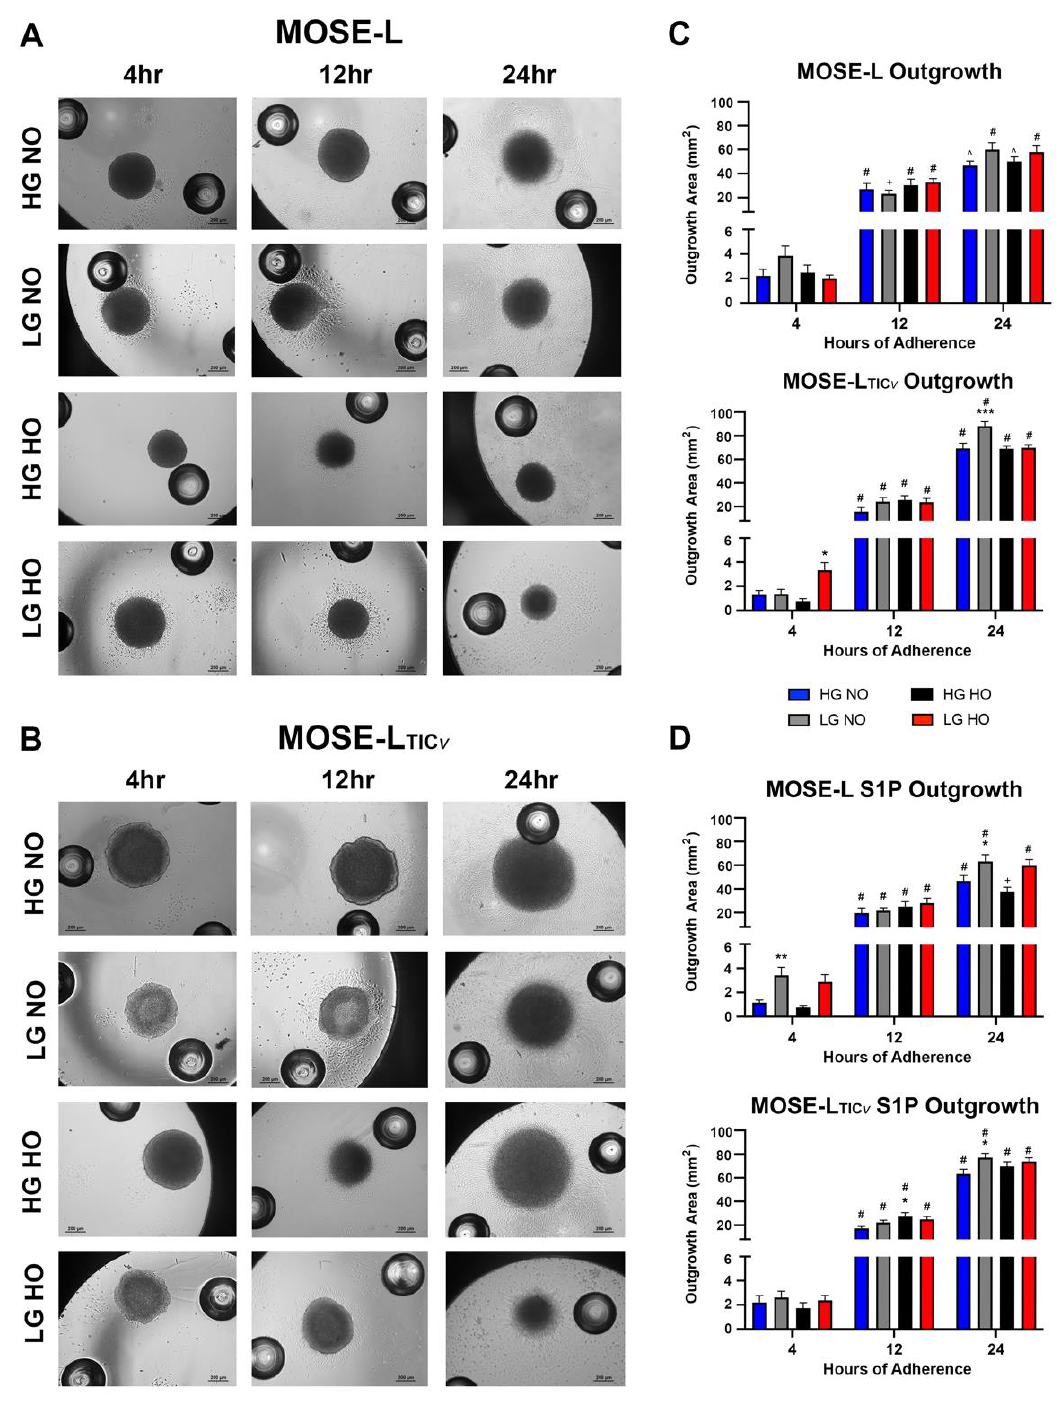
Figure 3. Spheroid outgrowth increased over time of adherence. Outgrowth of spheroids was measured in MOSE-L and MOSE-L TICv in brightfield images quantified using NIS Elements and ImageJ ( A ) Representative images of MOSE-L spheroids ( B ) Representative images of MOSE-L TIC v spheroids, ( C ) Quantification of outgrowth for MOSE-L and MOSE-L TICv spheroids, and ( D ) for S1P-treated MOSE-L and MOSE-L TICv . Data are represented as the mean ± SEM. * p < 0.05 compared to HG NO; ** p < 0.01 compared to HG NO; *** p < 0.001 compared to HG NO. + p < 0.05 compared to previous time point; ˆ p < 0.01 compared to previous time point; # p < 0.001 compared to previous time point. Abbreviations: high glucose (HG); low glucose (LG); normoxia (NO); hypoxia (HO).